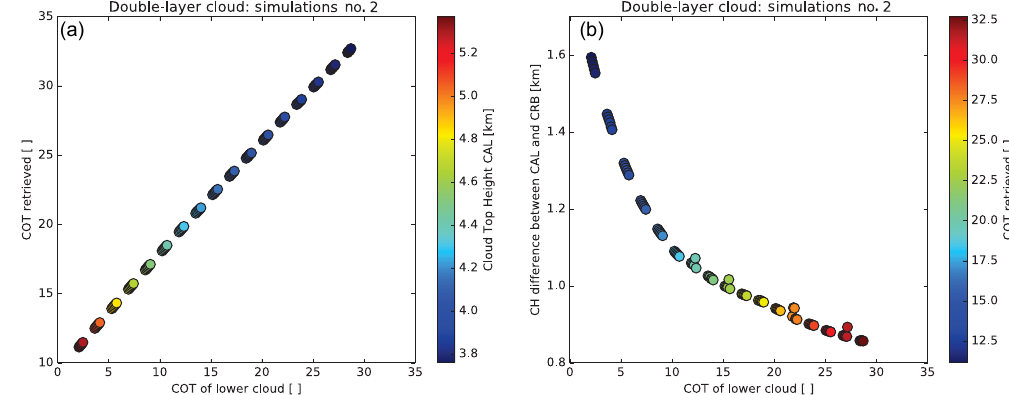
Figure 6. (a) Retrieved cloud top height and cloud optical thickness from ROCINN_CAL for the second group of simulations (i.e. a low cloud with cloud top height of 2km, cloud geometrical thickness of 1km, and cloud optical thickness in the range 2–30, plus a mid-level cloud with cloud optical thickness of 10, cloud top height of 6km, and cloud geometrical thickness of 2km). (b) Differences in cloud height retrieval between CRB and CAL as a function of the optical thickness of the low cloud.